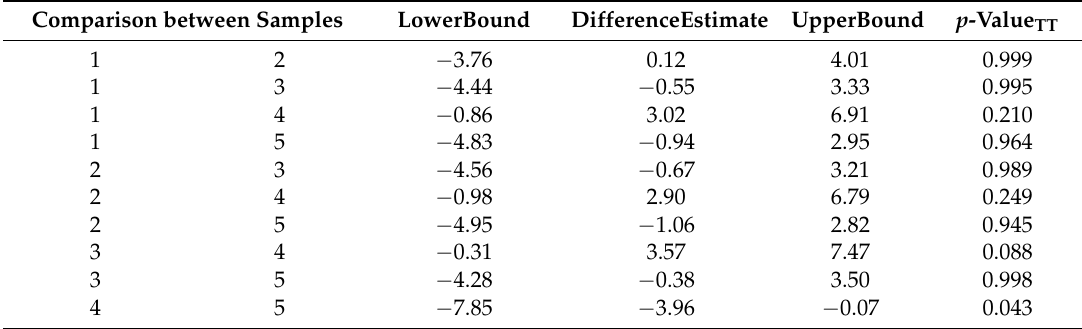
Table 8. One-to-one comparison of the means for the one-year analysis. Comparison between